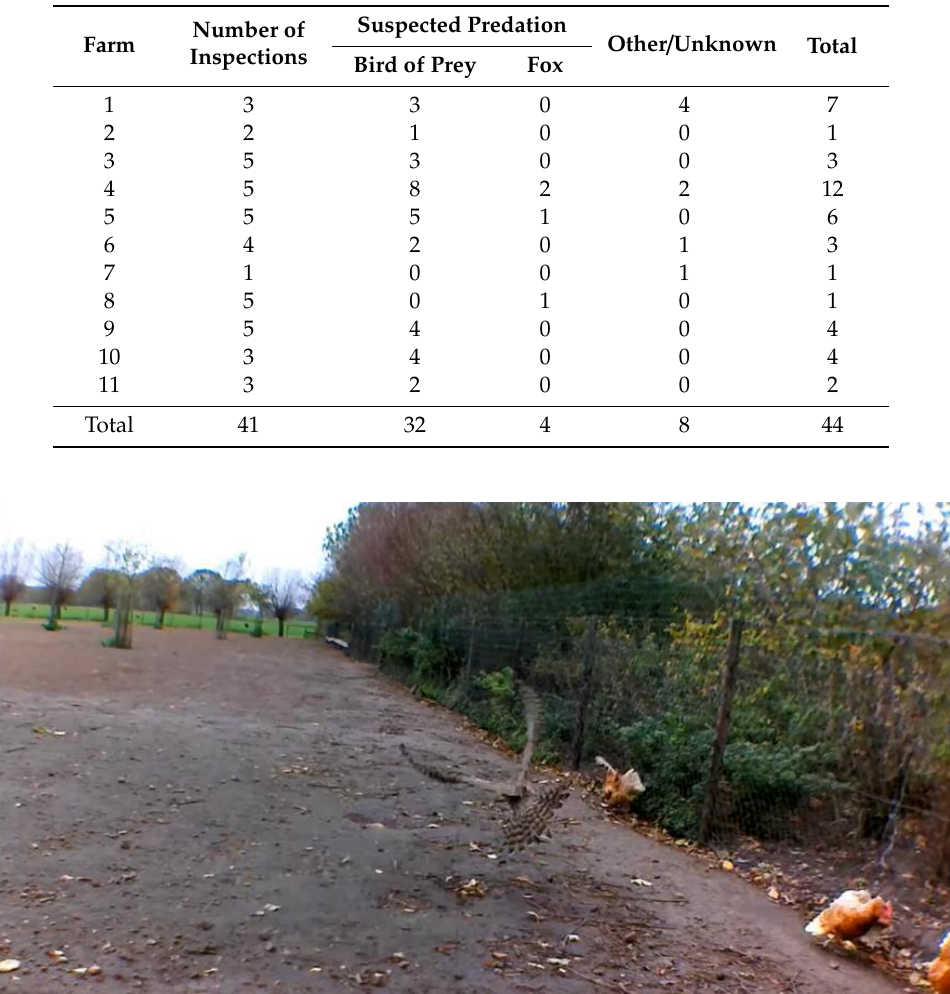
Figure 1. Northern goshawk ( Accipiter gentiles ) during attack 11.